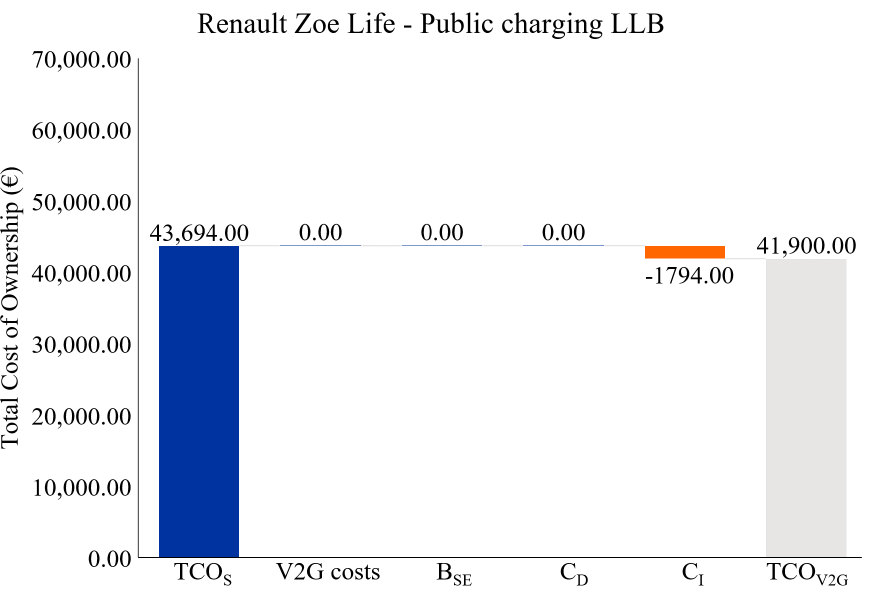
Figure A5. Standard and V2G TCO of a Renault Zoe in a public charging case providing LLB ( TCO S = Standard TCO, B SE = benefit of saved electricity costs from the grid, C D = direct compensa- tion, C I = indirect compensation, TCO V 2 G = V2G TCO); source: own